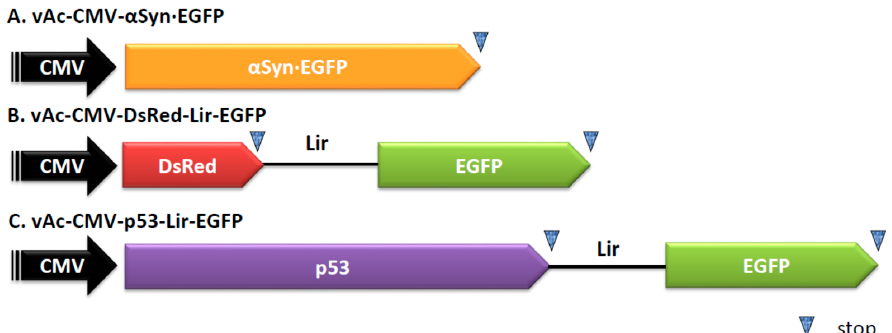
Figure 1. BacMam vectors used in this study. ( A ) vAc-CMV- α Syn·EGFP is the baculovirus that